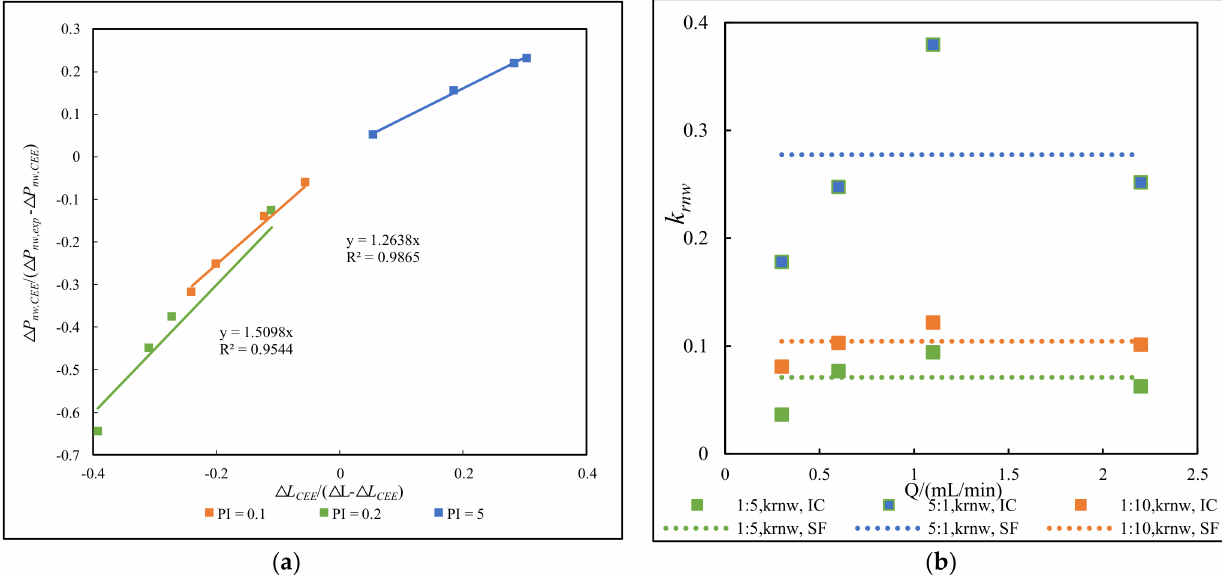
Figure 5. PI = 0.1 (orange); PI = 0.2 (green); PI = 5 (blue). The calculation and application of the stability factor: ( a ) Calculation of stability factor; ( b ) comparison of wetting phase correction results between the stability factor method (SF) and the intercept method